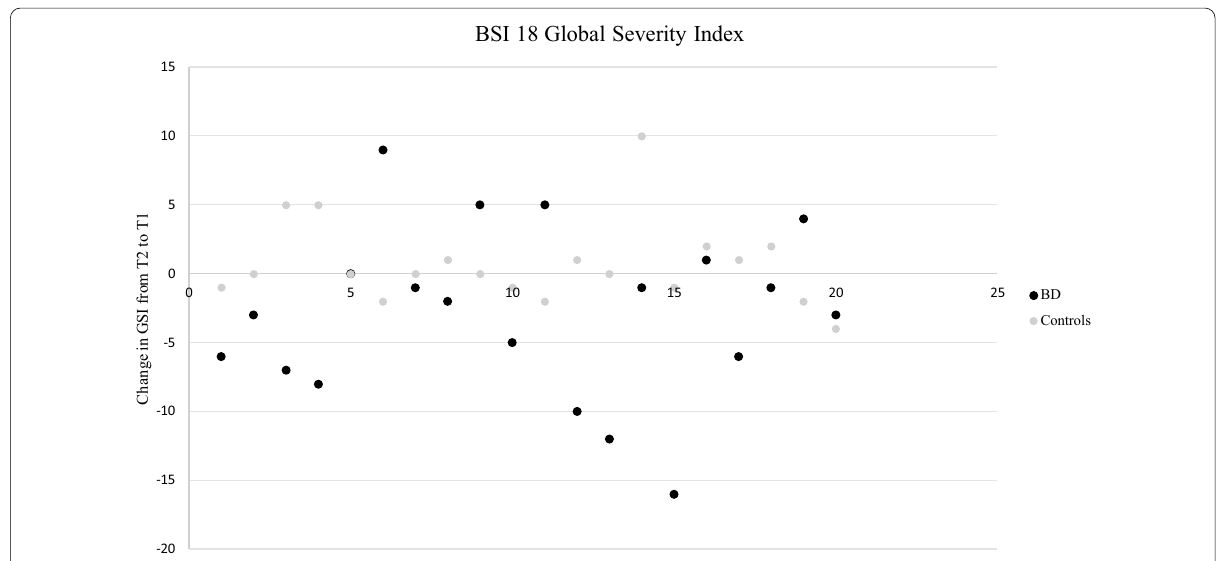
Fig. 2 Median change from T1 to T2 in BSI‑18 global severity index(GSI) BD bipolar disorder, GSI global severity index